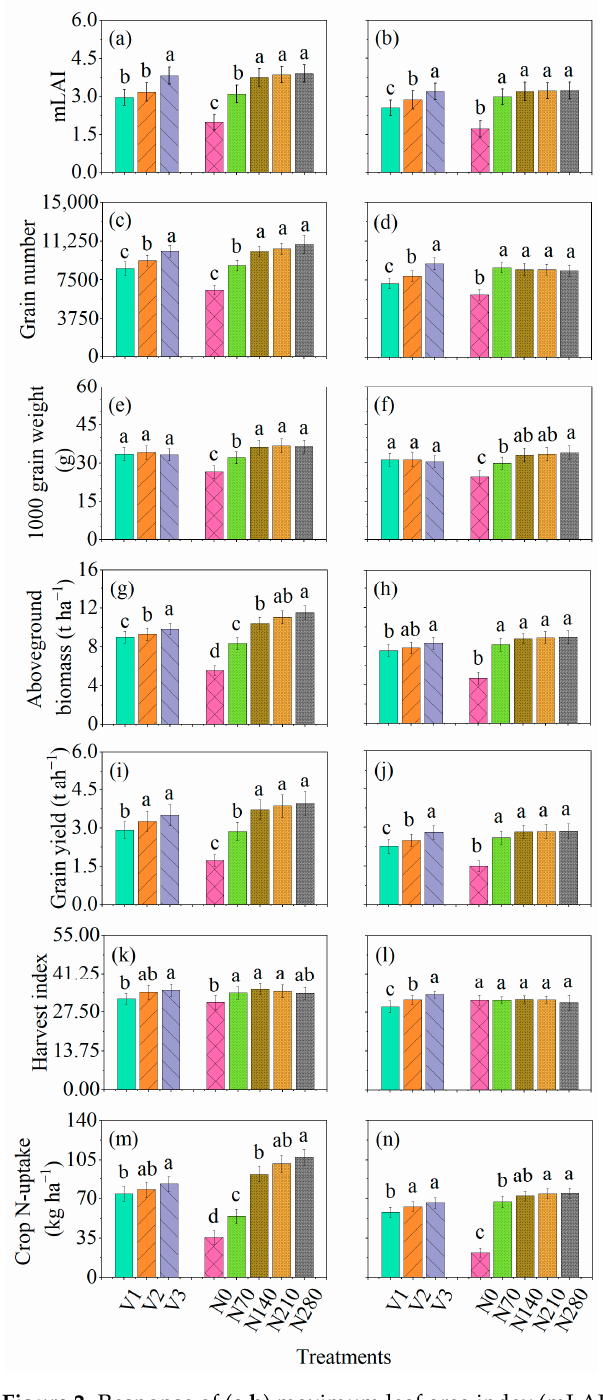
Figure 2. Response of ( a , b ) maximum leaf area index (mLAI), ( c , d ) grain number (m − 2 ), ( e , f ) 1000 grain weight (g), ( g , h ) grain yield (t ha − 1 ), ( i , j ) aboveground biomass (t ha − 1 ), ( k , l ) harvest index, and ( m , n ) crop N-uptake (kg ha − 1 ) for various cultivars and N application rates. The alphabets a, c, e, g, i, k, and m represent the first growing season (2013–2014), and b, d, f, h, j, l, and n represent the second growing season (2014–2015). V1, V2, and V3 represent AUR-809, CHK-50, and FSD-2008. Grain number was influenced by five sources of variation: season, genotype, N application rates, season × N application rates, and genotype × N application rates. However, grain weight was significantly affected by season and N application rates, with no interaction effects. Grain number and grain weight ranged from 6512 to 10,661 and 26.6 to 36.8 g during the favorable growing season (Figure 2c,e) and ranged from 6073 to 9080 and